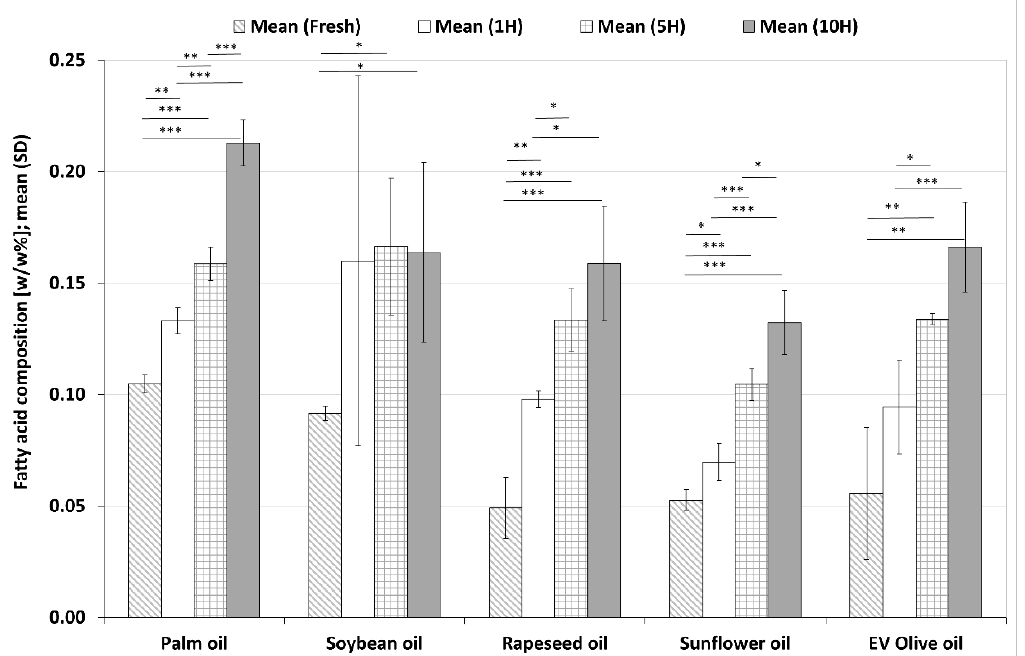
Figure 4. Changes in total trans fatty acid (TFA) values in five different plant-based oils in fresh samples and after one (1H), five (5H) and ten heating sequences (10H). Each column shows the mean (SD) data of six different chromatograms. Asterisks denote statistically significant differences between the different time points in the same oil; *: 0.01 ≤ p < 0.05; **: 0.001 ≤ p < 0.01; ***: p < 0.001. EV olive oil: extra virgin olive oil.